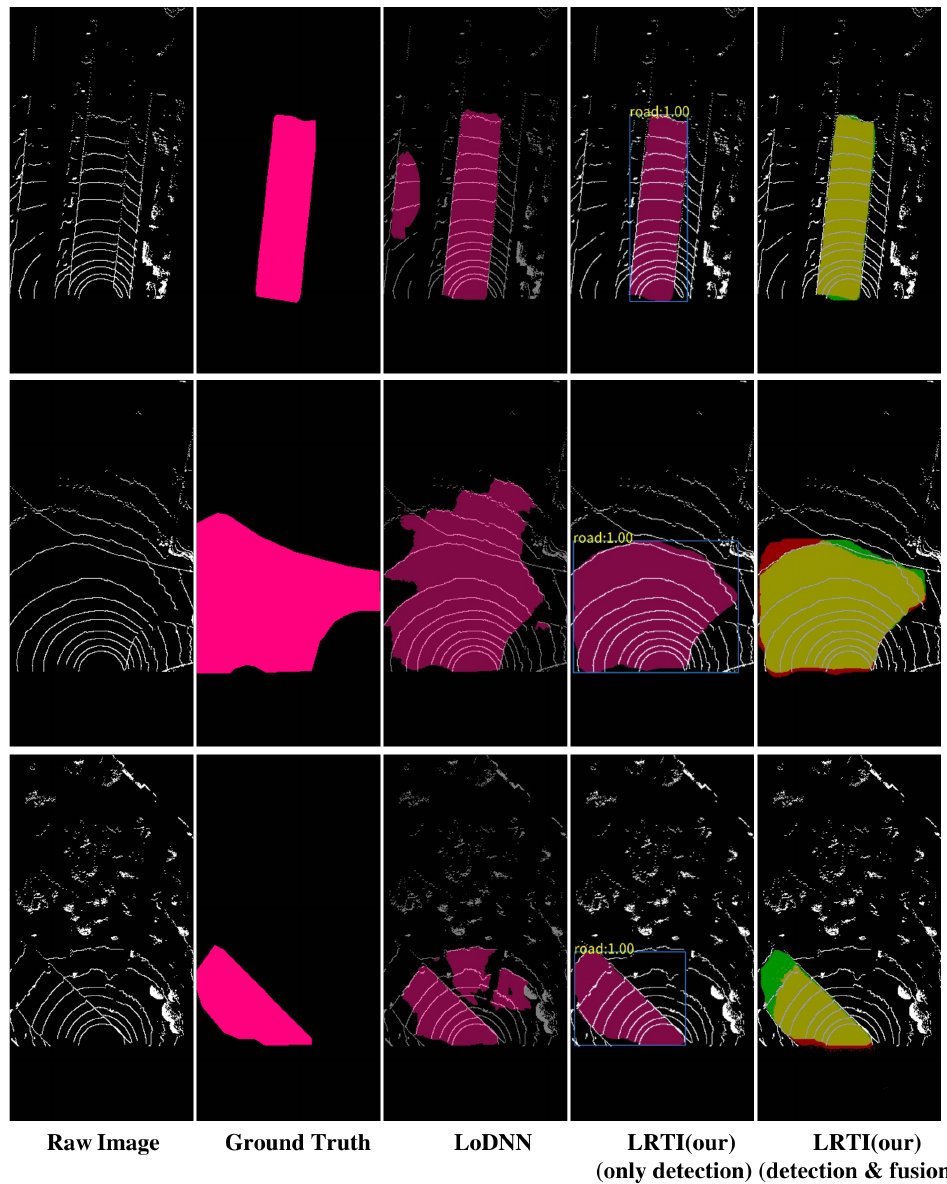
Figure 10. Experimental results in various environments. The proposed method not only works on off-road scenarios, but also in urban